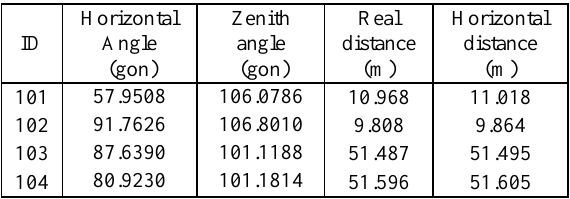
Table 4. Polar coordinates of the markers